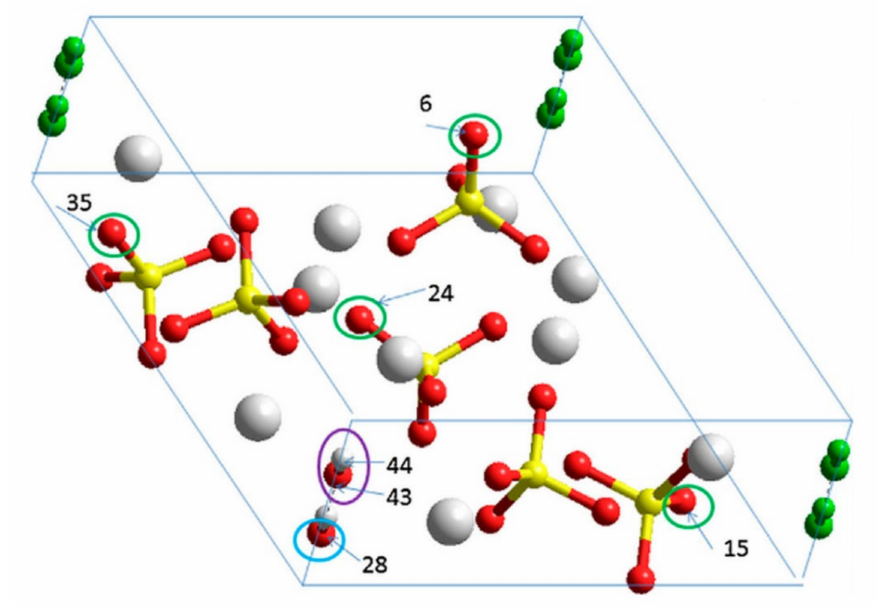
Figure 2. Models and scheme of the atomic positions selected and deleted for modelling presentation of various vacancy-defects in the HAP hexagonal unit cell with initial 44 atoms. Indicated in the colored circles are: (1) in blue—oxygen atom (number 28) from an OH group for creation of an O-vacancy in the OH-channel; (2) in purple—OH group full (with atom numbers 43 and 44) for creation of a complete OH-vacancy; (3) in green—oxygen atoms (with numbers 6, 15, 24, 35) from various differently positioned PO 4 groups corresponding to an O-vacancy in PO 4 groups. The green atoms on the other three corners indicate other OH groups, which belong to neighboring periodical repeated unit cells. (Adapted with permission from ref. [6]; Elsevier,